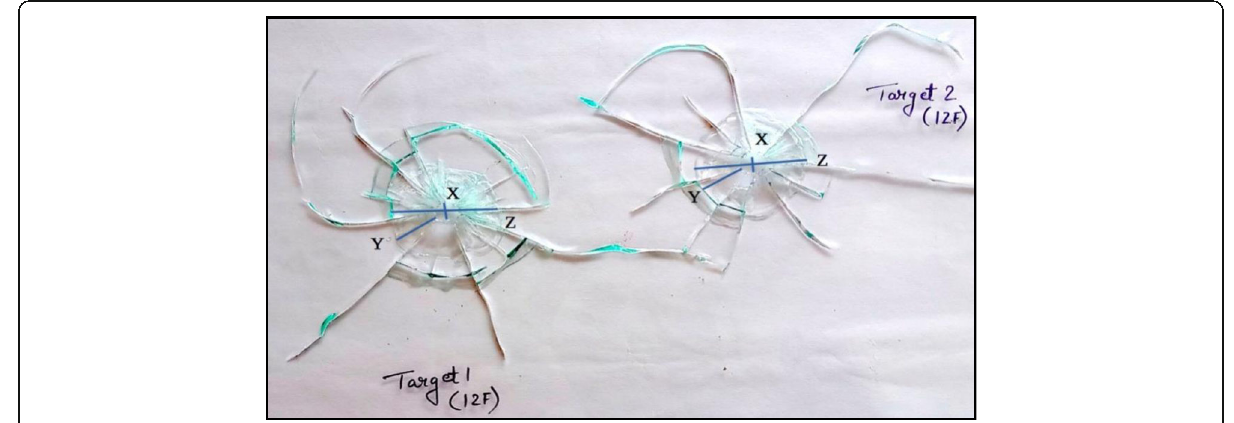
Fig. 2 Representation of the parameters: the hole diameter ( X ), diameter of mist zone ( Z ), thickness of mist zone ( Y